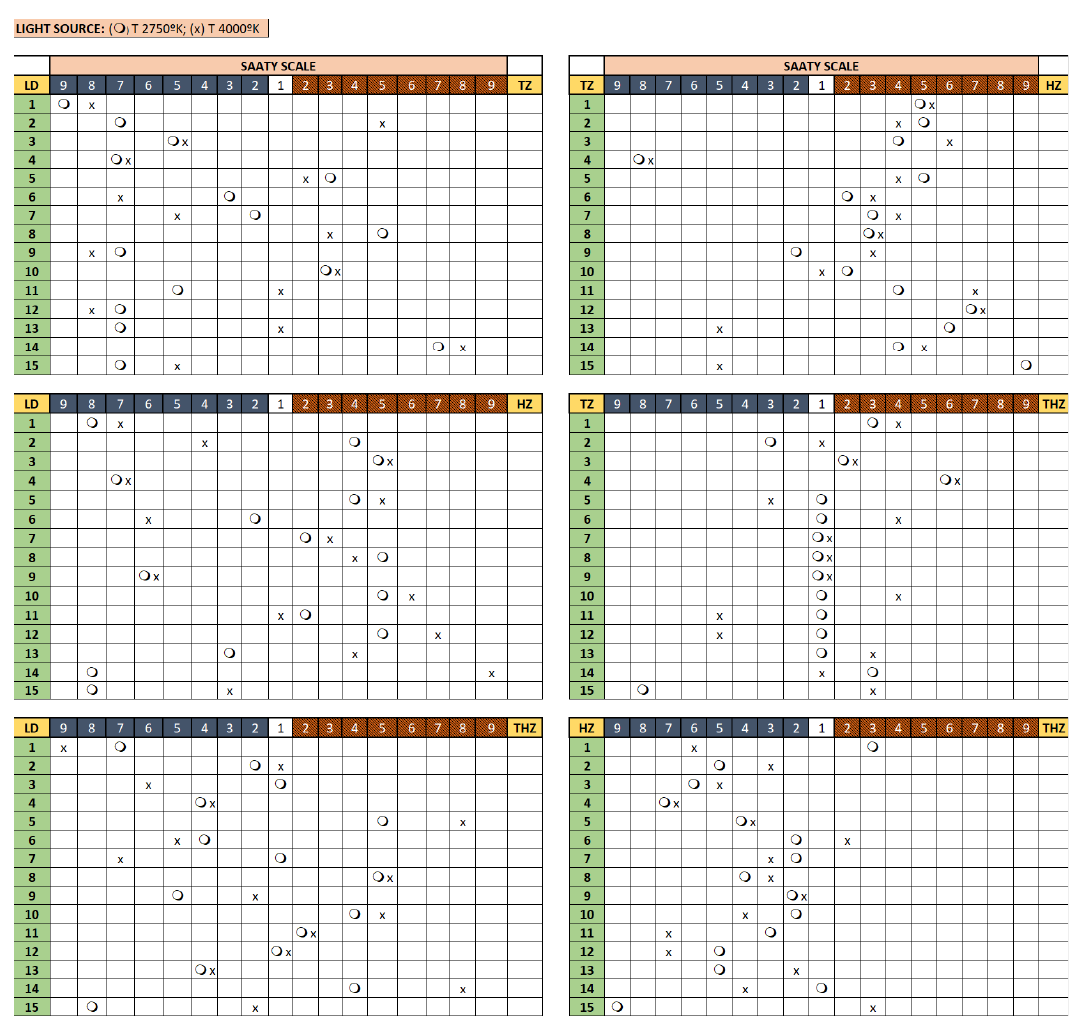
Figure 5. Results obtained after Saaty’s analysis when the materials where paired compared.